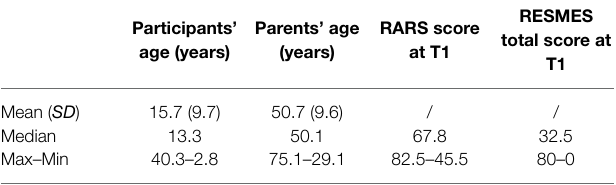
TABLE 1 | Descriptive statistics of participants’ and parents’ age, Rett syndrome (RTT) severity level at T1 [measured with Rett Assessment Rating Scale (RARS)] and level of motor functioning at T1 [measured with Rett Syndrome Motor Evaluation Scale